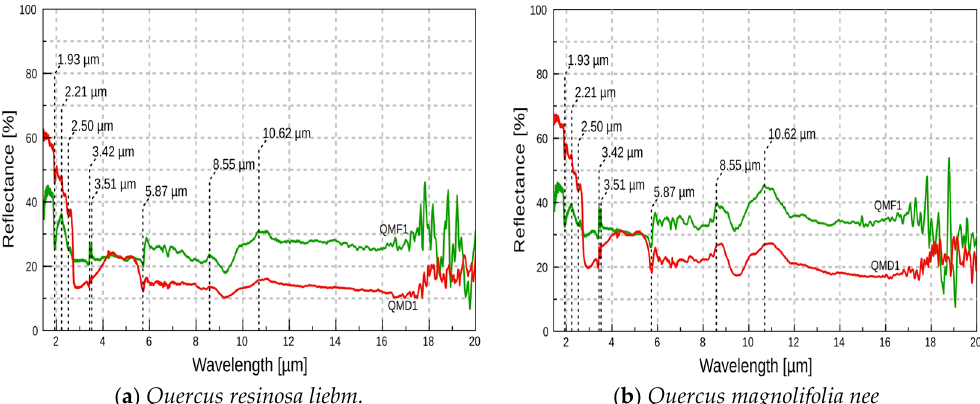
Figure 3. Fourier transform FT-IR reflectance spectrum of ( a ) Quercus resinosa Liebm. and ( b ) Quercus magnoliifolia Née from 1.4–20 µm (after [9]). Green line denotes the spectrum of a fresh leaf (green, upon visual inspection), and the red one corresponds to the senescent leaf (brown, upon visual